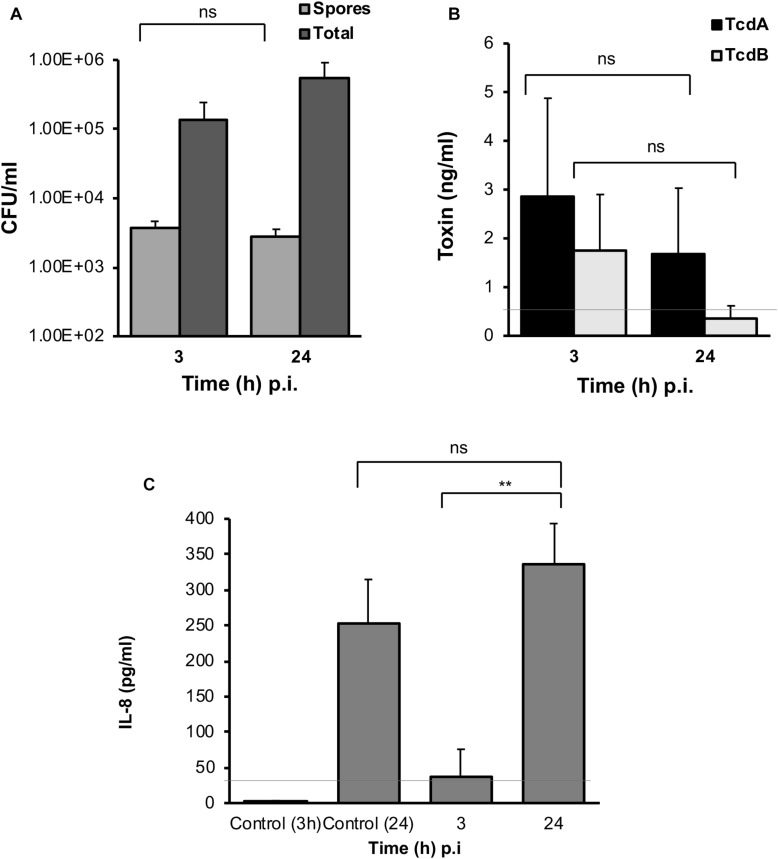
C. difficile spores and toxin production, and host response to infection in the 3D-VDC model. (A) Colony counts of spores and total cells in the host cell-associated C. difficile fraction (infected cell lysates). Data shown are the mean of three independent experiments and error bars indicate SD, ns, not significant as determined by two-way ANOVA. (B) Toxin A and B levels from apical compartment supernatants as determined by ELISA in the 3D model. Data shown are the mean of three independent experiments and error bars indicate SD, ns, not significant as determined by two-way ANOVA. Gray line represents the sensitivity of the test at 0.5 ng/ml. (C) Human IL-8 levels in supernatants from the basolateral compartments with uninfected cells incubated for 24 h or with cells infected with C. difficile for 3 and 24 h, as determined by ELISA. Gray line represents the limit of detection at 32 pg/ml. Data shown are the mean of three independent experiments and error bars indicate SD, **p < 0.01, as determined by the one-way ANOVA with Tukey’s test for multiple comparison.